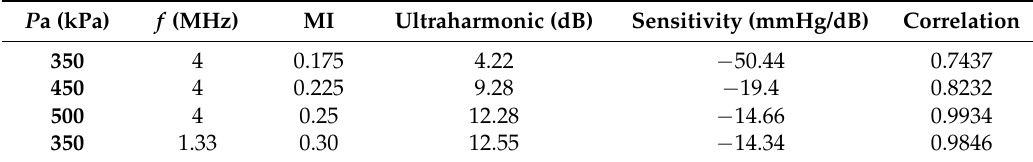
Table 3. Ambient pressure sensitivity of the ultraharmonic